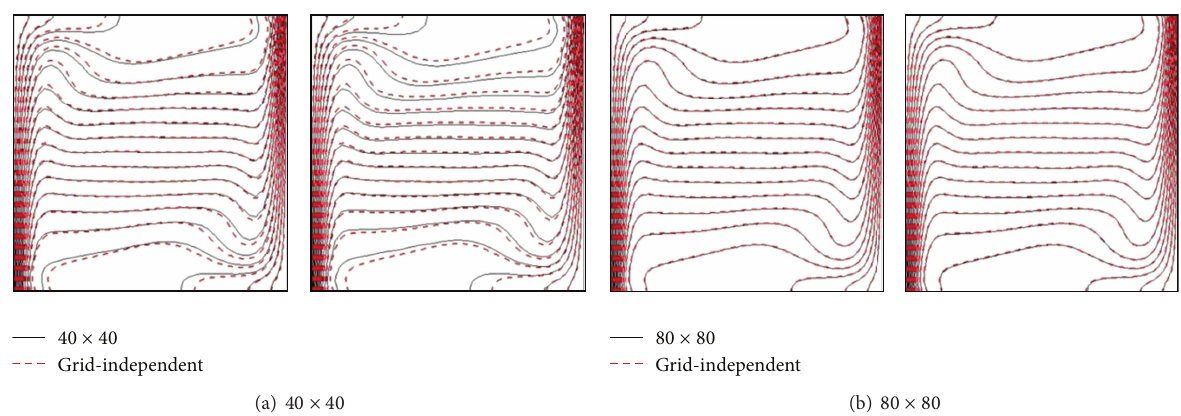
Figure 7: Comparison of temperature contours of natural convection flow in a square cavity with variant mesh densities (FVM in the left column and FDM in the right